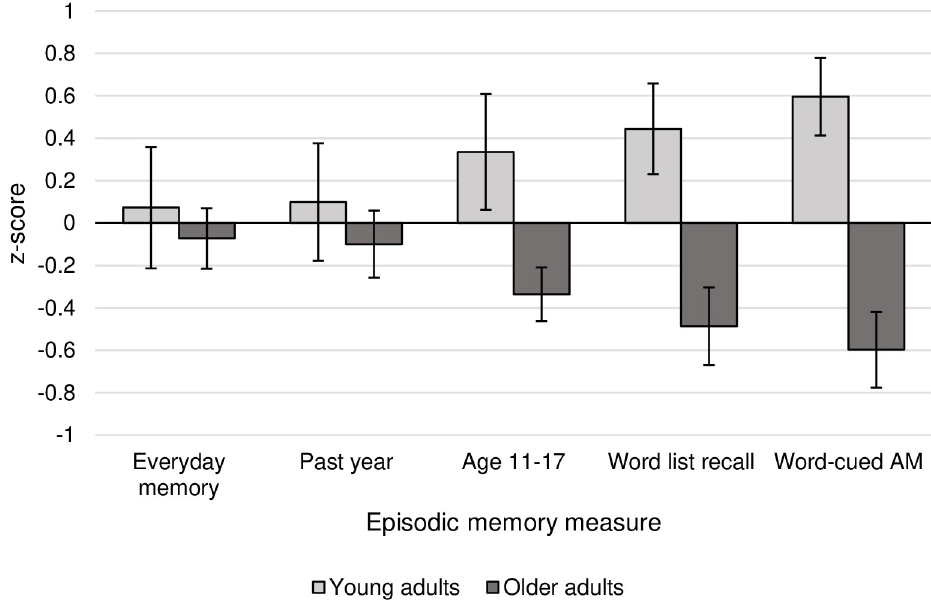
Fig 1. Older and younger adults’ relative performance on episodic memory measures, plotted as z -scores and presented in order of the magnitude of the between-group difference. Error bars represent standard error.